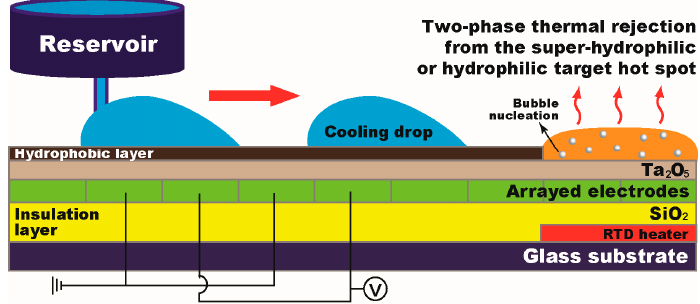
Figure 2. A schematic of the single-sided digital microfluidic (SDMF) device and the